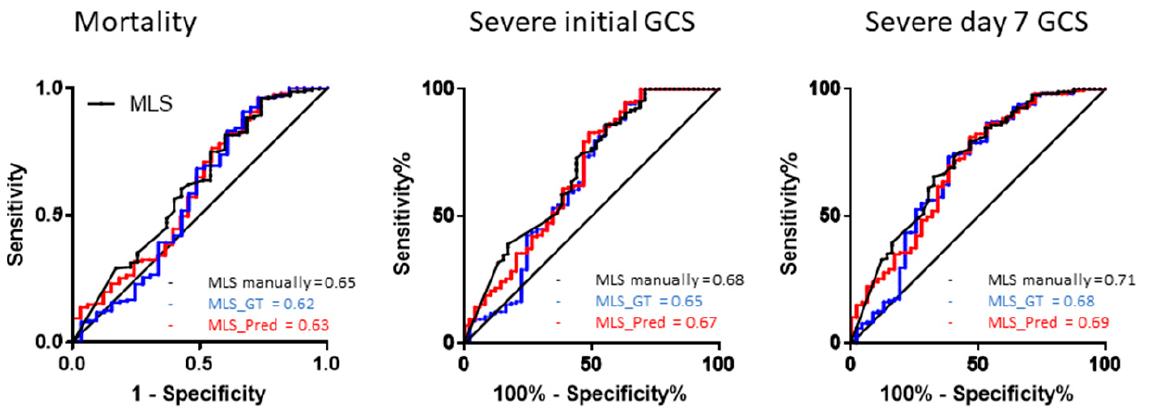
Figure 5. Figure 5 shows the receiver operation curve of MLS measurement by using manual drawing, key point detection and automatic detection methods for the prediction of 30-day mortality and initial and day 7 severe GCS (GCS < 9). There was no difference between different methods.